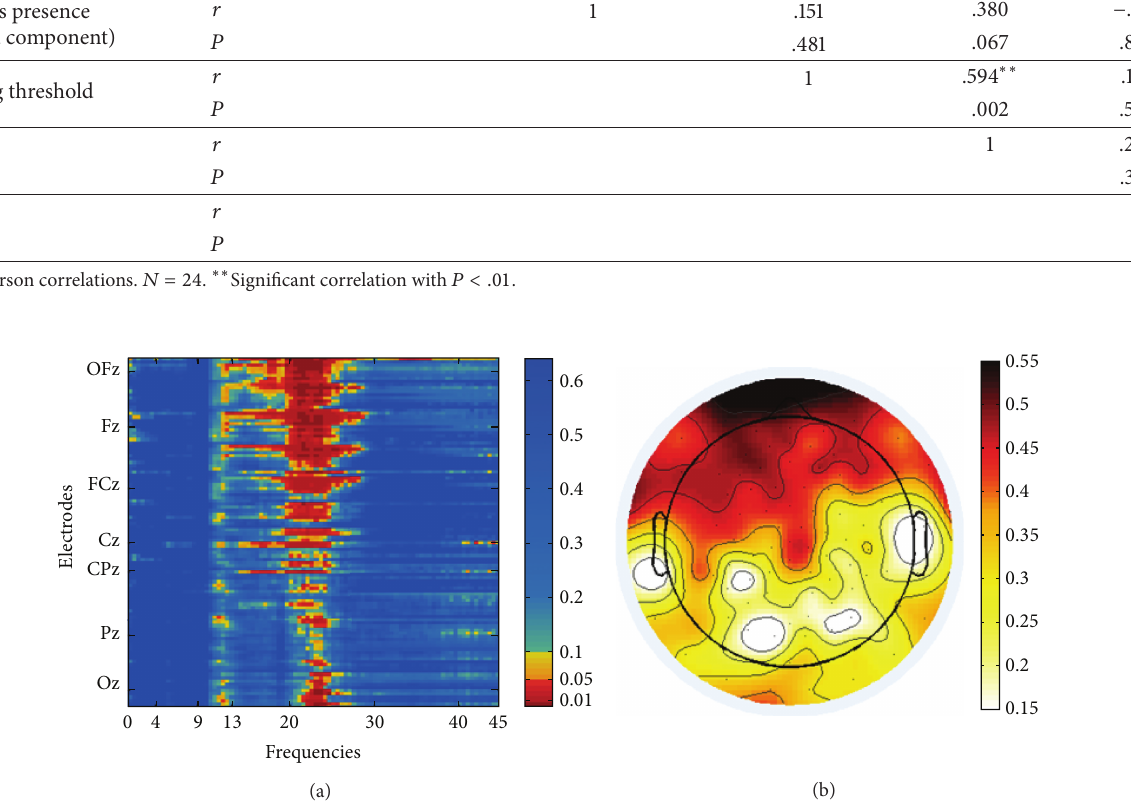
Figure 3: (a) Nonnormalized EEG spectral power adjacency matrix of Pearson product-moment correlations with tinnitus distress. Significance levels ( 𝑃 values) of the correlations are color-coded (one-sided, uncorrected for multiple comparisons). On the 𝑦 -axis electrodes are aligned from rostral (top) to caudal (bottom), irrespective of laterality. Positions of electrodes on the central line are marked. (b) Topographic plot of EEG power correlations in the upper 𝛽 -band (20–25 Hz) with tinnitus distress and strength of correlations (Pearson’s 𝑟 ) are